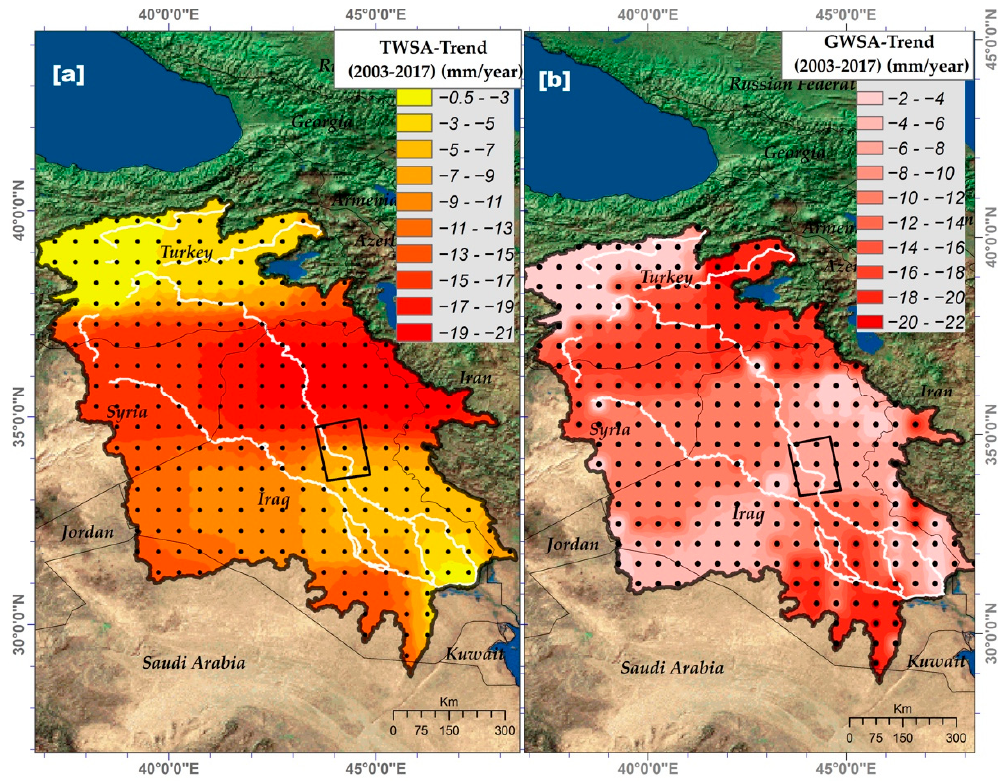
Figure 4. ( a ) The spatial variations of the TWS and ( b ) groundwater storage (GWS) trends from 2003 to 2017 in TEB using Equations (1)–(3) for the WGHM model. The black rectangle shows the Sentinel-1 scene. The significant trend is marked by black dots based on p -value < 0.0001.